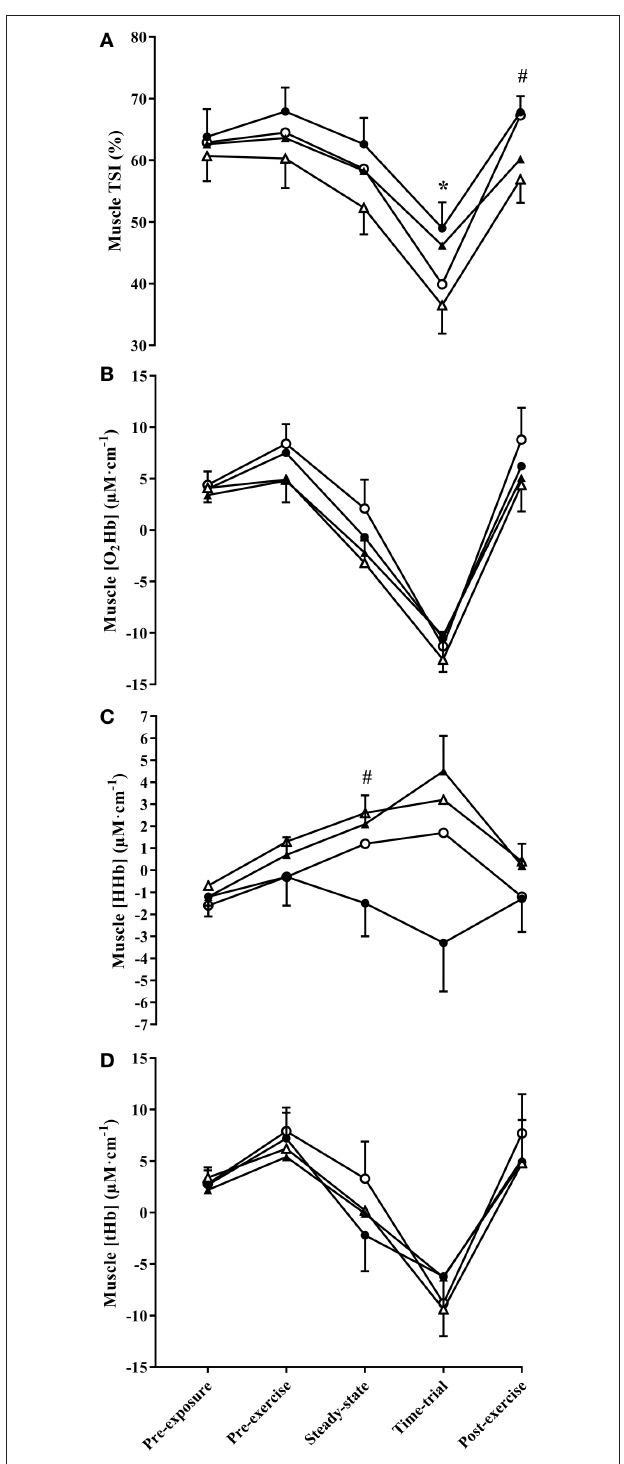
FIGURE 3 | Muscle TSI (A) , and the change in muscle oxyhaemoglobin concentration ([HbO 2 ]) (B) , deoxyhaemoglobin concentration ([HHb]) (C) , and total hemoglobin concentration ([tHb]) (D) throughout experimental trials at 3,000 and 4,300m simulated altitude following nitrate-rich beetroot juice (BRJ) and nitrate-deplete placebo (PLA) supplementation. Closed